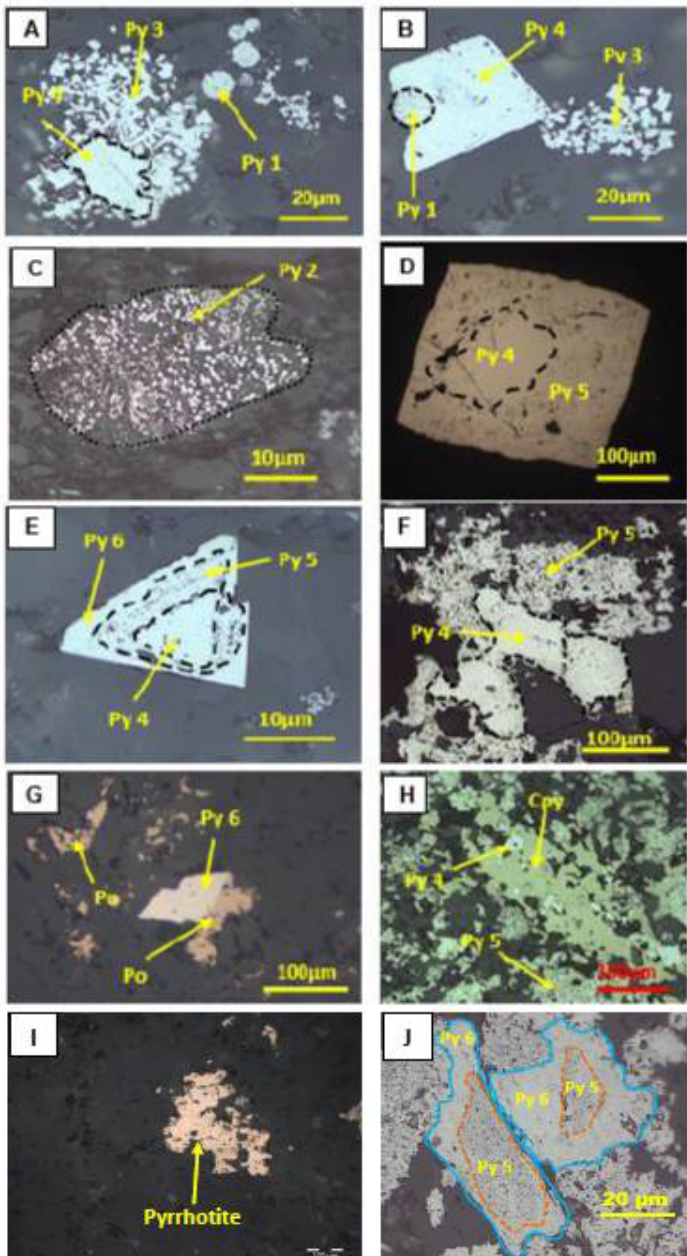
Figure 4. Textural characteristics of pyrite with other sulfide minerals in the Singa Formation, Malaysia. ( A ) Diagenetic pyrites (py 1), microcrystals of euhedral pyrite 3, and clean subhedral pyrite 4 (sample LA-3812A). ( B ) Diagenetic pyrite 1 overgrown by euhedral pyrite 4 and associated with pyrite 3 (sample LA-3812B). ( C ) Aggregate of micro-nodules of pyrite (py 2) (sample LA-3812C). ( D ) Subhedral pyrite 4 overgrown by pyrite 5 (sample LA-5312). ( E ) Zoned pyrite grain showing pyrite 4 (core) overgrown by pyrite 5, which in turn, rimmed by pyrite 6 (sample LA-3812A). ( F ) Pyrite 4 associated with pyrite 5 (sample LA 4112). ( G ) Pyrite 6 and pyrrhotite (po) in the form of patches which size ranges from 5 to 200 µm across (sample LA-4112). ( H ) Chalcopyrite (cpy) formed around microcrystals of pyrite 4 associated with pyrite 5 (sample LA-4112). Sample identification: LA-3812 and LA-4112 represent black shales; LA-5312 is a sandstone sample. ( I ) Pyrrhotite in slate (sample LA-4212). ( J ) Inclusion-rich pyrite 5 overgrown by pyrite 6 (sample